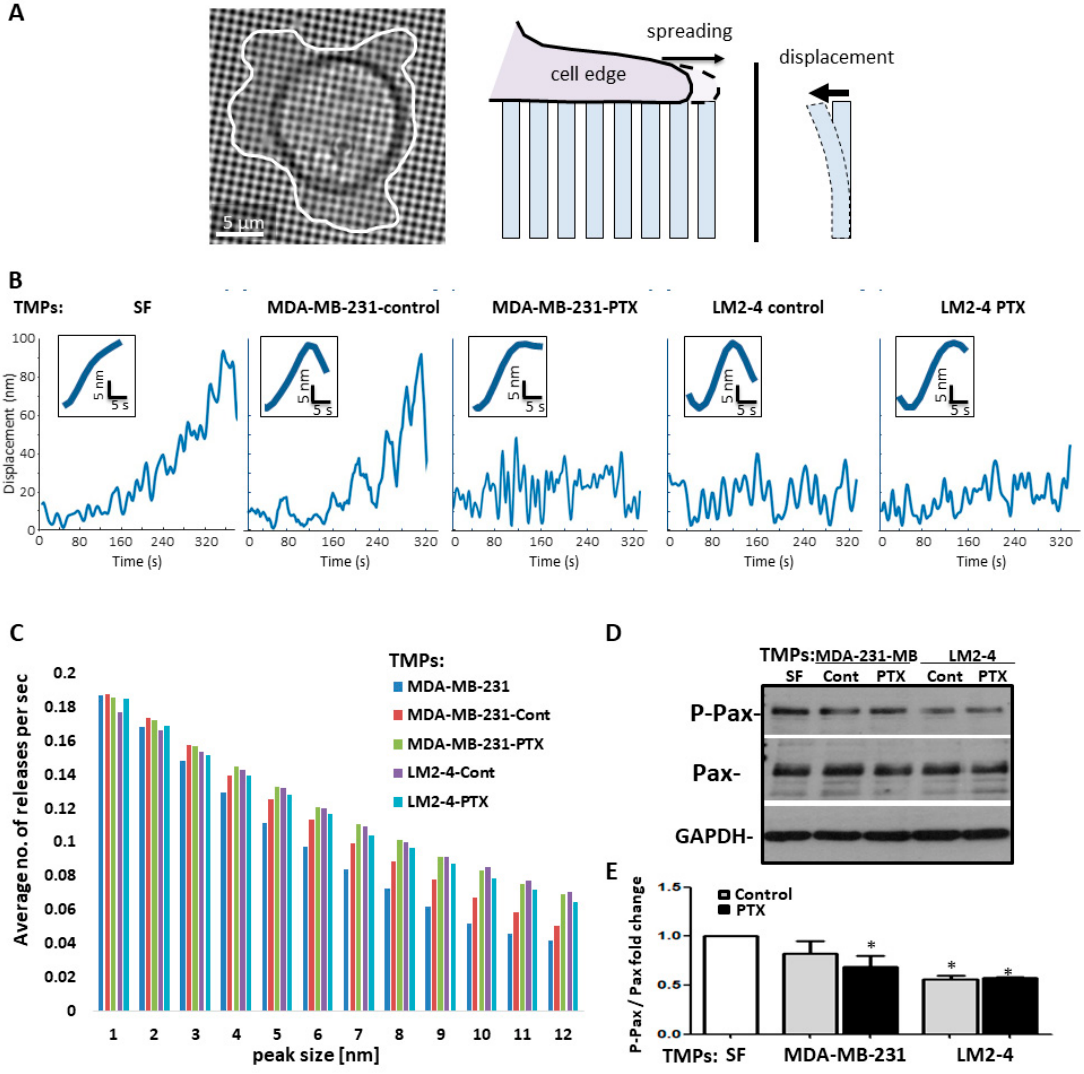
Figure 4. TMPs from highly metastatic cells or cells exposed to chemotherapy increase the pace of cell biomechanical forces and inhibit focal adhesion signaling. ( A – C ) MDA-MB-231 cells cultured with TMPs from MDA-MB-231 or LM2-4 cells exposed to PTX or vehicle control were applied on a pillar assay, as described in Materials and Methods. MDA-MB-231 cells cultured with serum-free medium (SF) were used as a control. ( A ) Left: Example of a cell spreading on an array of 0.5 µm diameter fibronectin-coated pillars (see illustration on the right). ( B ) Typical pillar displacement curves. ( C ) Histograms presenting the average number of pillar releases per second binned according to the size of the release. Each of the control conditions was significantly different than the conditions in which the cells were exposed to TMPs from LM2-4 cells or from cells exposed to PTX ( α < 0.01; Kolmogorov–Smirnov test). n = 8–10 repeats/group. ( D – E ) Cells treated as above were seeded on fibronectin-coated plates to evaluate phospho-paxillin (P-Pax) and total-paxillin (Pax) expression by Western blot. GAPDH was used as a loading control ( D ). The ratio between P-Pax over Pax was calculated based on densitometry, and presented as fold change, for three biological repeats ( E ). n = 3 repeats/group. * differences compared to MDA-MB-231 control group, * p < 0.05, as assessed by one-way ANOVA followed by Tukey post-hoc test.